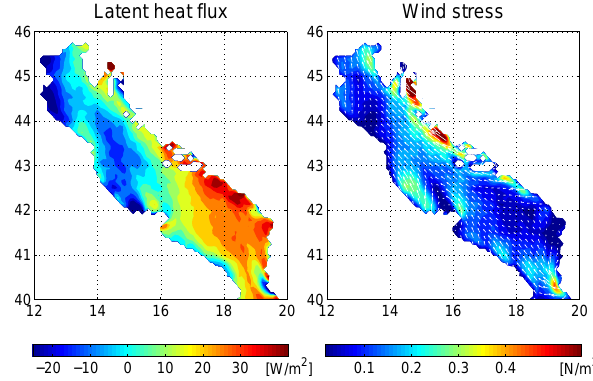
Fig. 4. ALADIN surface wind field (vectors and shaded; left panel) and surface wind curl (shaded; right panel) at 00:00 UTC on 28 December 2002 for the Gargano area. Orography contours shown are the same as in Fig. 1.